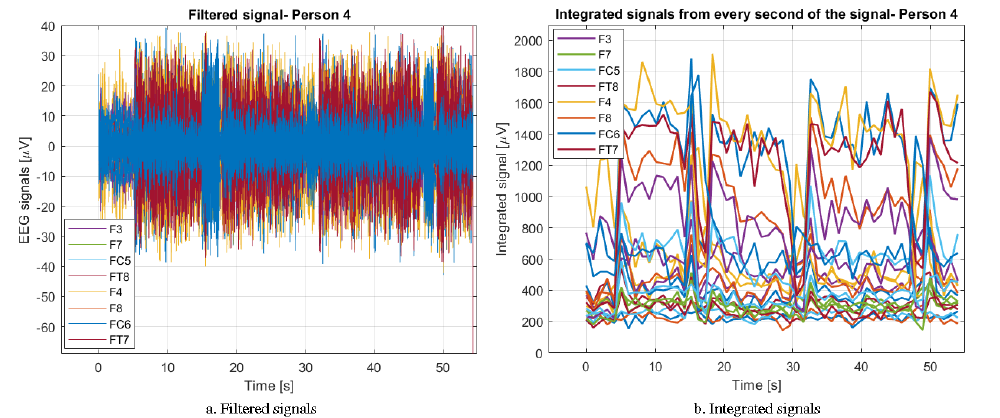
Figure 9. Comparison of filtered and integrated signals—Person 4.